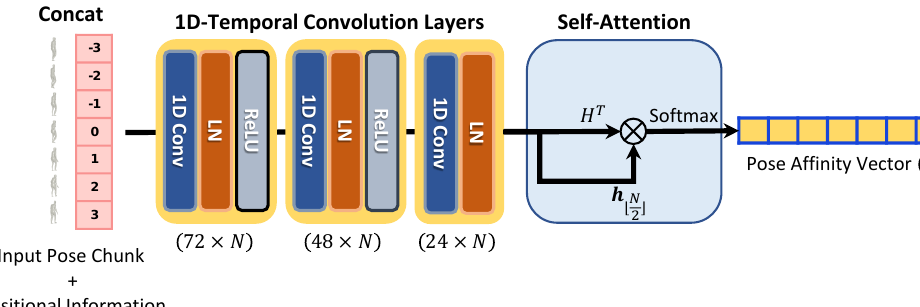
Figure 3. Detailed pipeline of the weight-regression module. ⊗ represents matrix multiplication. First, the weight-regression module concatenates positional information to an input pose chunk. Second, the positional encoded input chunk is fed into the weight-regression module that consists of three 1D temporal convolution layers. Finally, pose affinity vector is generated from the output temporal feature of the convolution